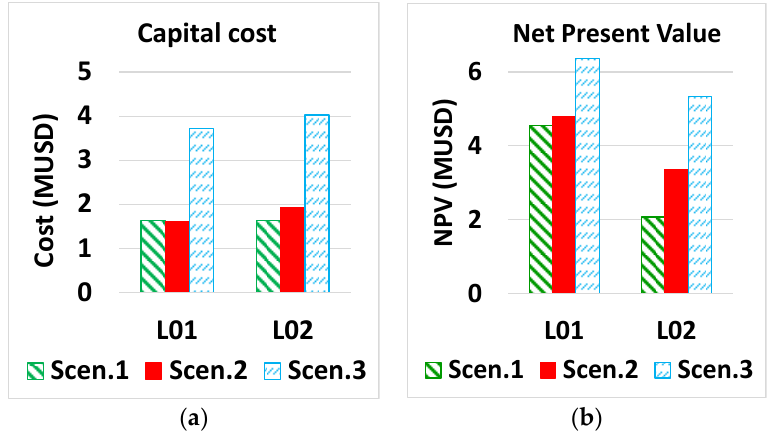
Figure 15. Capital cost ( a ) and net present value ( b ) for the scenarios and the two load types.